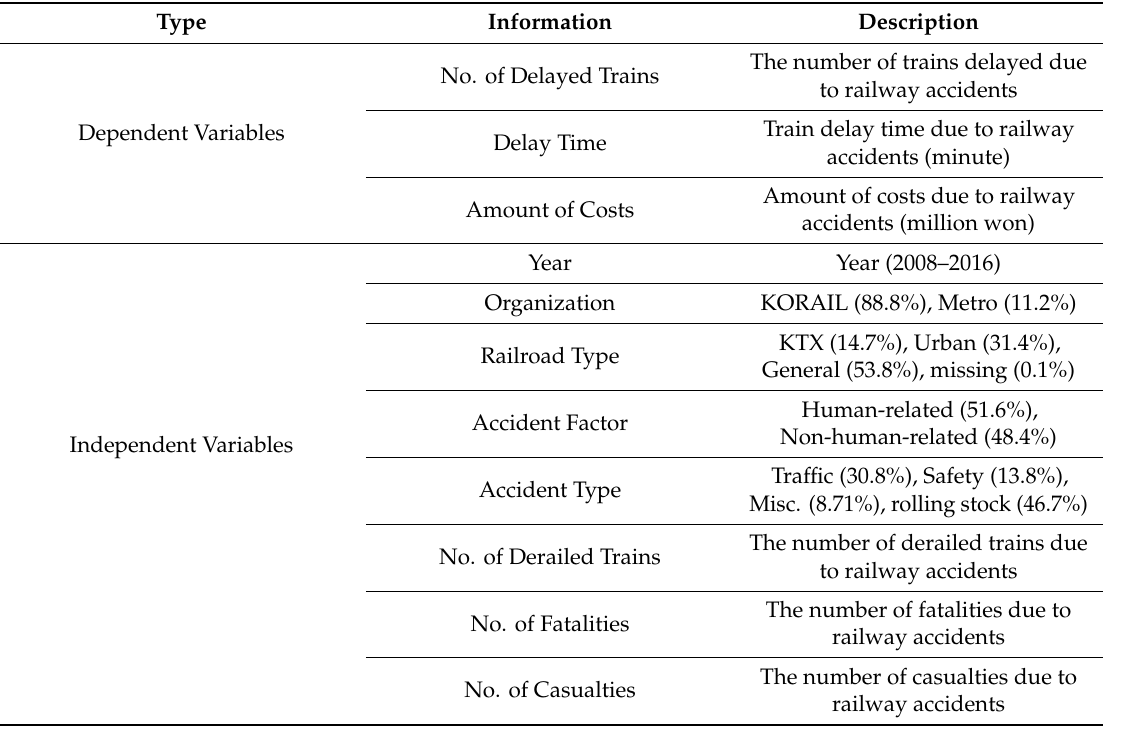
Table 2. Description of the Variables in Korea Transportation Safety Authority (KOTSA) Railway Accidents